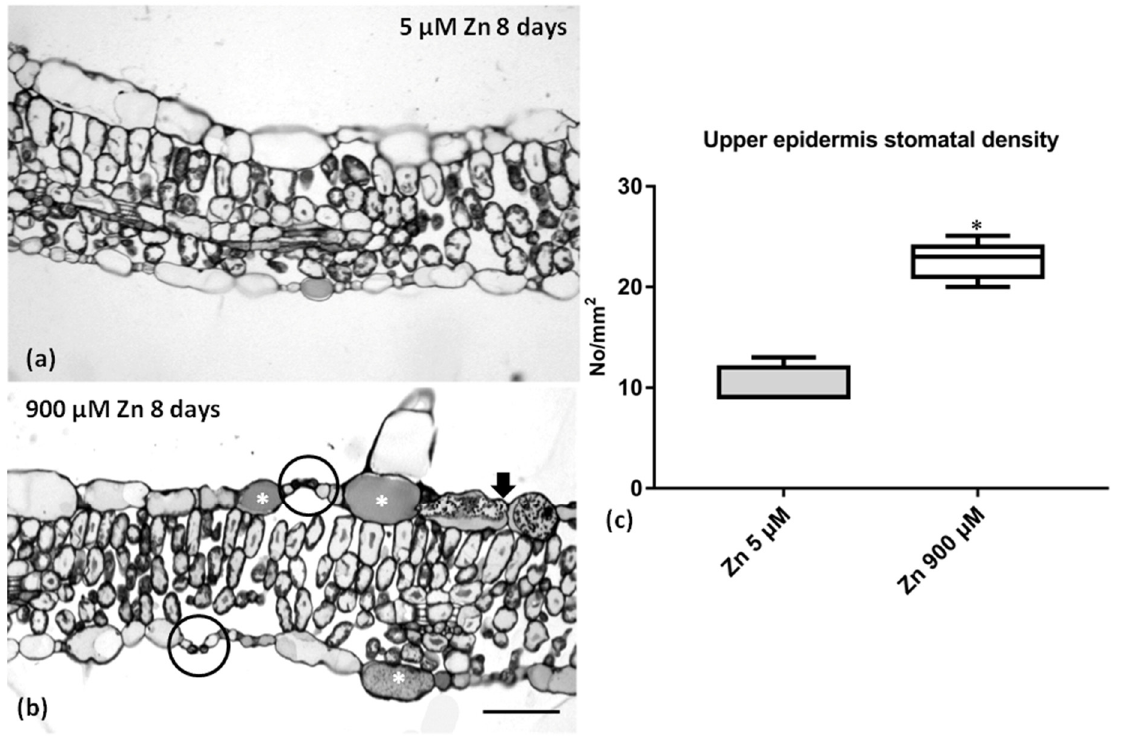
Figure 7. Transverse sections of S. sclarea leaves from ( a ) 5 µM (control) or ( b ) 900 µM (excess) Zn 8-day-treated plants. ( c ) Stomatal density (No/mm 2 ) in the upper epidermis of both control and excess Zn-treated plants. Upon excess Zn application, some additional stomata could be observed (circles in ( b )), while the epidermal cells contained darkly stained materials (asterisks and arrows in ( b )). ( c ) Data are presented as means from sections from 4 individual leaves (* p < 0.05). Scale bar: 100 µm.